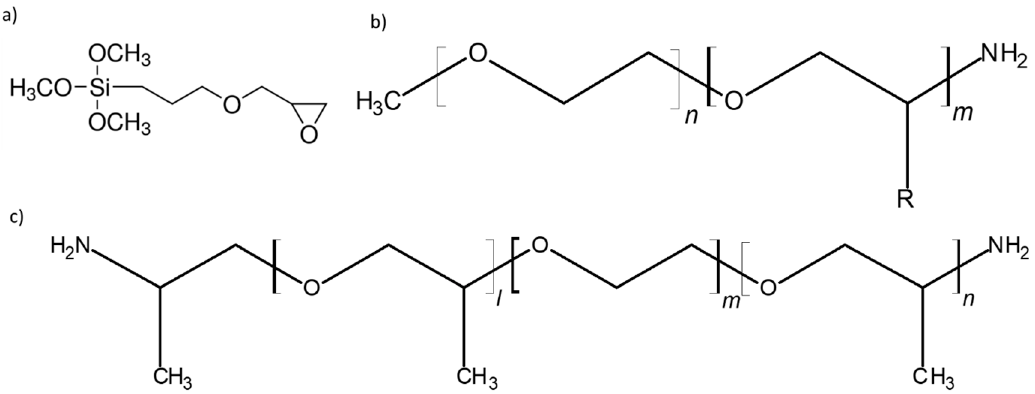
Figure 9. Structures of ( a ) (3-glycidyloxypropyl)trimethoxysilane (GLYMO), ( b ) Jeffamine M-2070, and ( c ) Jeffamine ED2003.